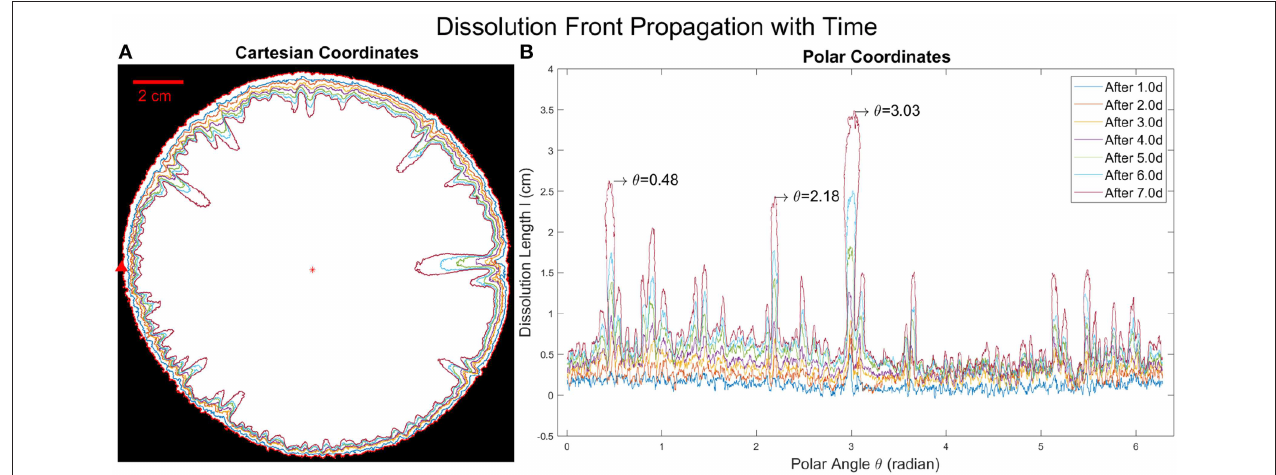
FIGURE 3 | (A) Dissolution front propagation with time in Cartesian coordinates. The outermost red circle is the initial boundary, the red star marks the origin, where the outlet is located. The red arrow shows the point where θ = 0 and the direction in which the polar angle increases. Different colors of the curves show the dissolution front in different times with the time interval of 1 day between two neighboring curves. (B) The evolution of the dissolution length with time is shown in polar coordinates, obtained by calculating l ( θ , t ) = D ( θ , t = 0) − D ( θ , t ) from binary experimental images. Different colors represent different times corresponding to the colors in (A) . The longest finger located at θ = 3.03 radians and the two second longest fingers located at θ = 0.48 radians and θ = 2.18 radians are indicated in the plot.